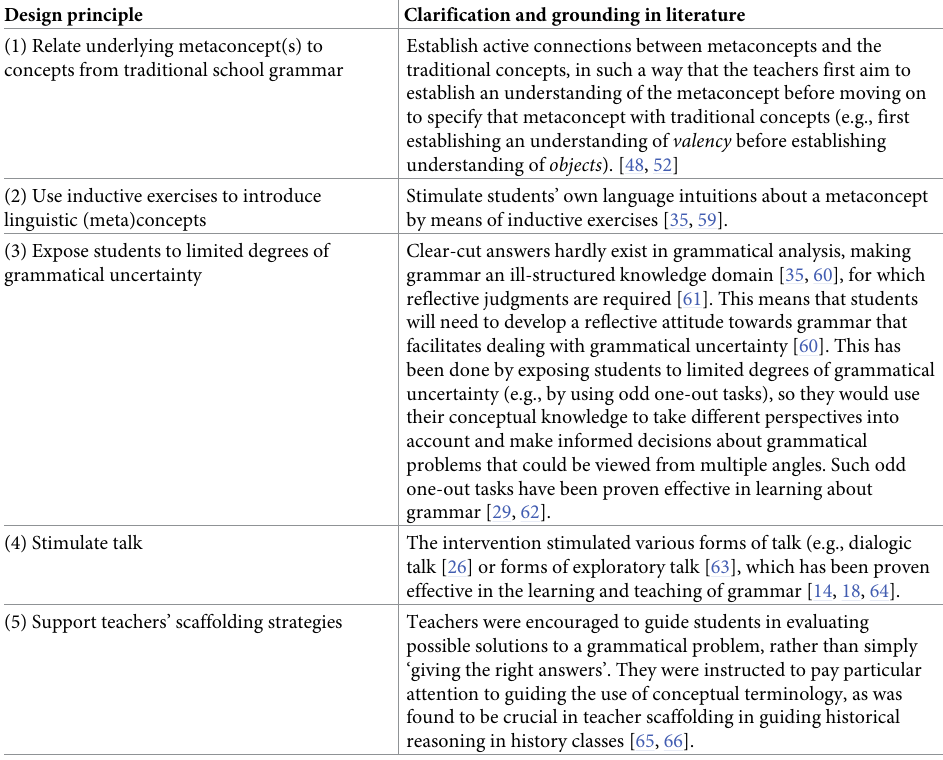
Table 1. Explanation of the design principles from the Van Rijt et al. [56] study, adopted in the current